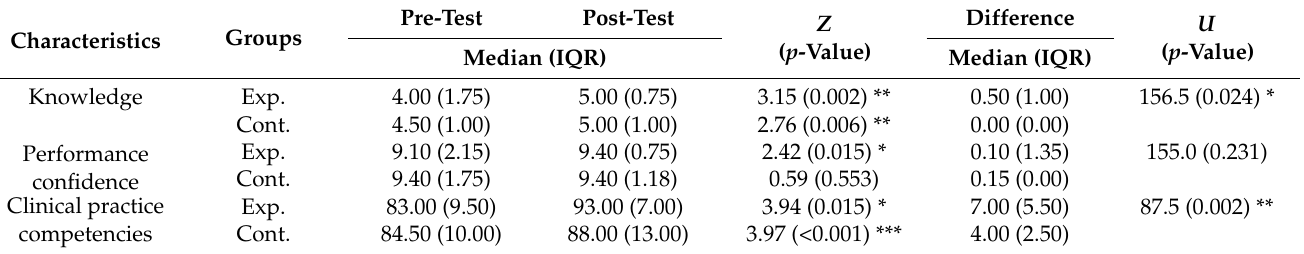
Table 2. Comparison of knowledge, performance confidence and clinical practice competencies within two groups ( n =